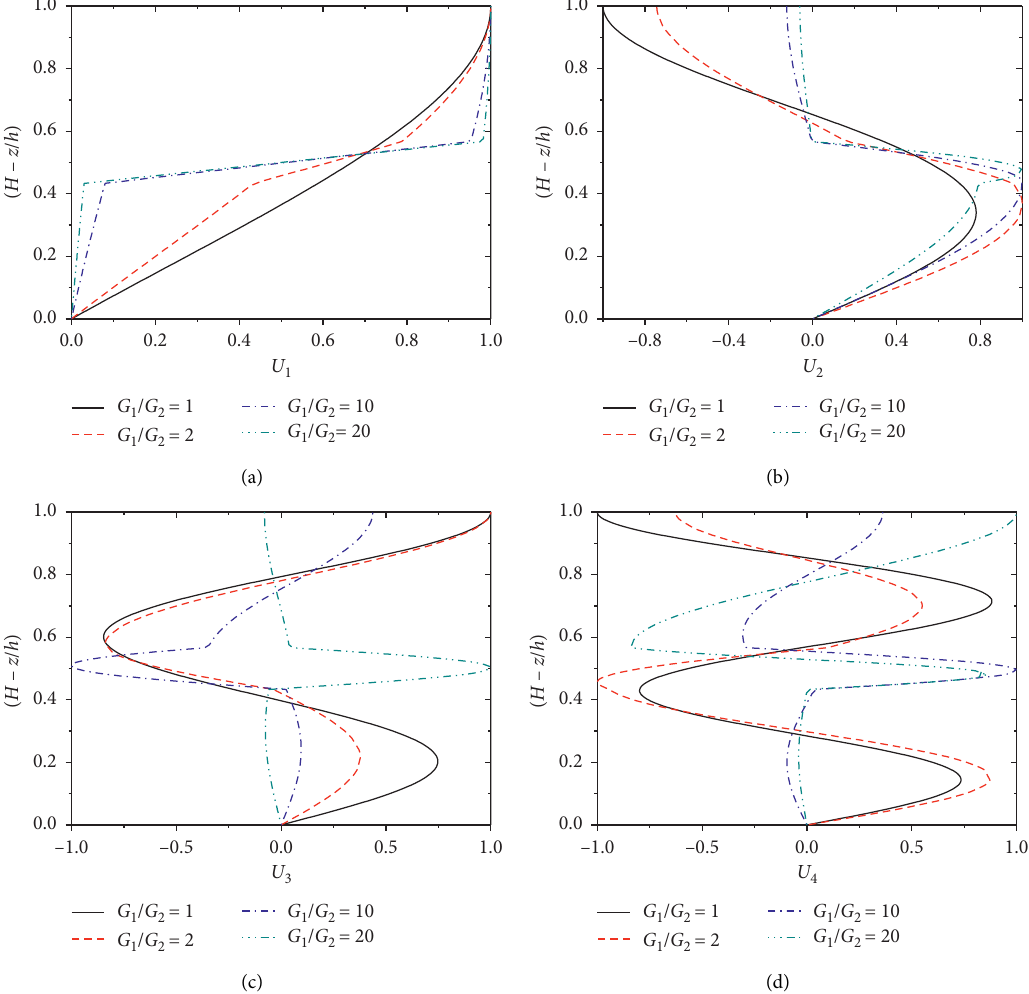
Figure 10: Displacement functions of first four vibration modes under different natural periods. (a) First vibration mode. (b) Second vibration mode. (c) Third vibration mode. (d) Fourth vibration